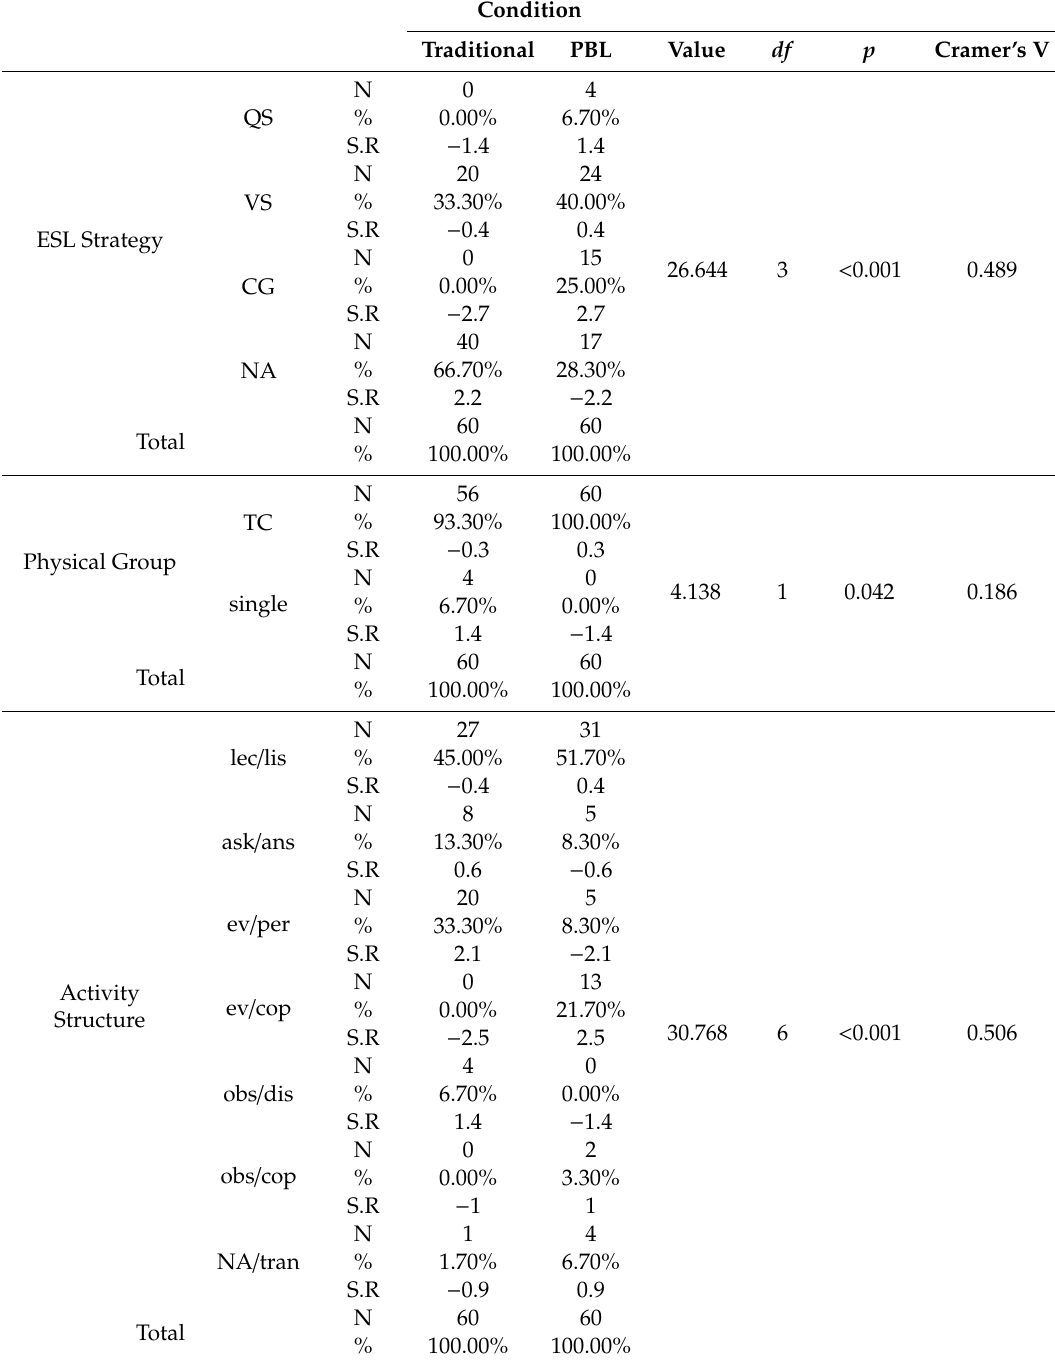
Table 2. Chi-square statistics of instructor’s pedagogical behaviors in the essay structure module between the PBL and traditional